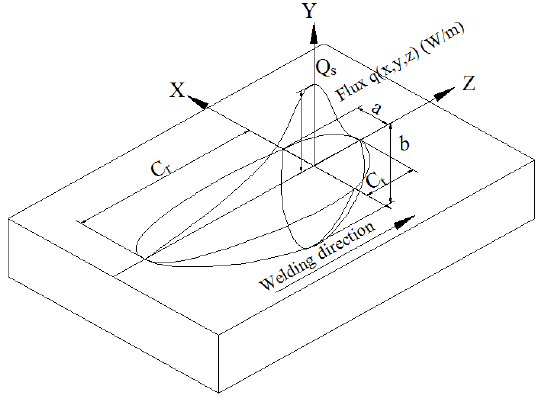
Figure 2. Ellipsoid Gaussian heat source distribution model.